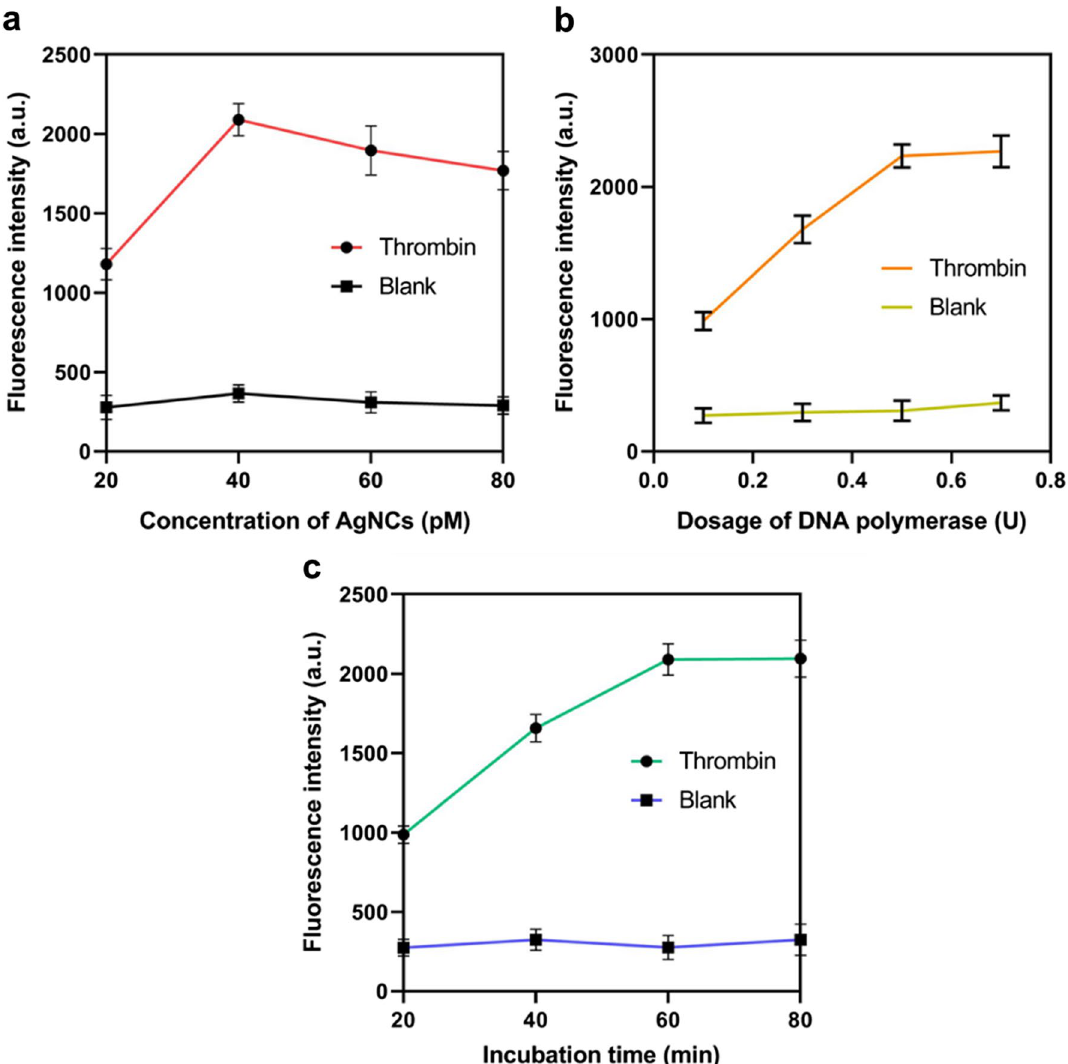
Fig. 3 Optimizations of experimental conditions. Fluorescence intensities of the approach with different concentrations of a DNA-templated AgNCs, b DNA polymerase, and c incubation